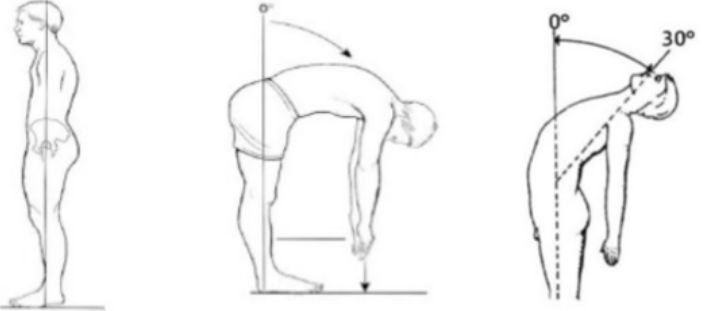
Figure 1. Flexion and extension range of motion (ROM) assessment.